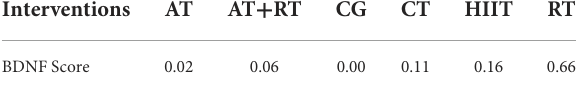
TABLE 6 Probability ranking results of different outcome indicators for each intervention.